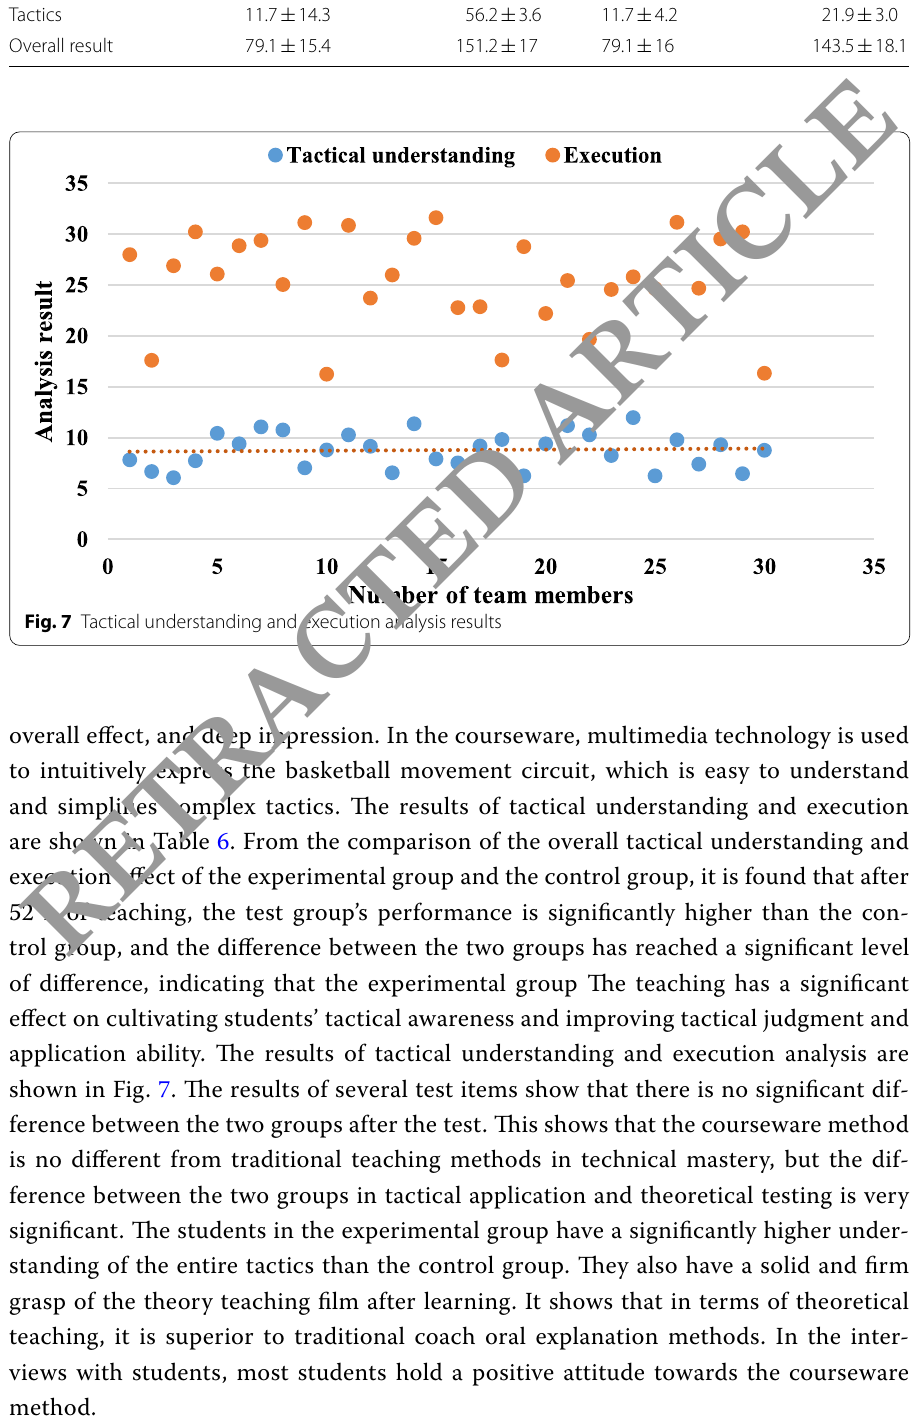
Table 6 Tactical understanding and execution effect results Content Test Control Before experiment After test